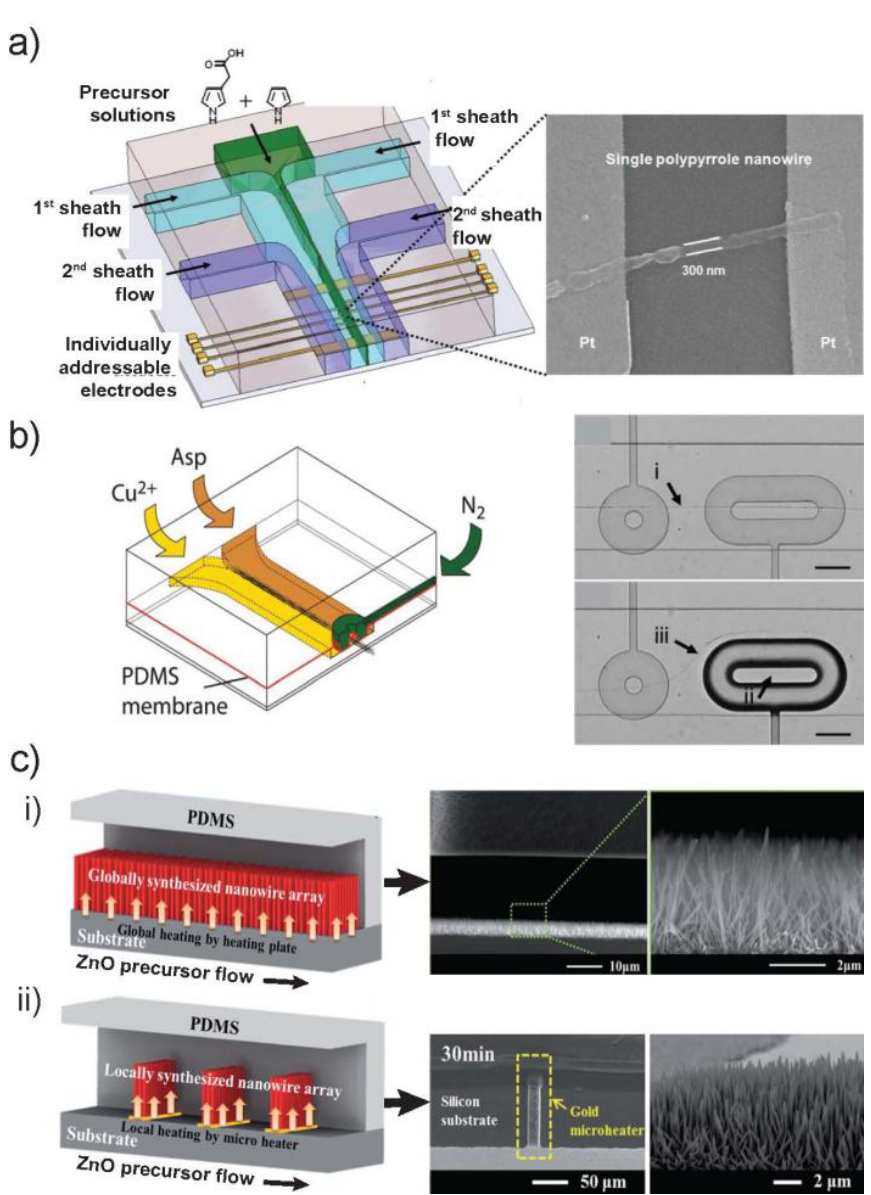
Figure 5. Alignment during synthesis. ( a ) Left: A microfluidic setup with a hydrodynamically focused laminar stream of two precursor solutions is used as a dynamic template for site-specific electrochemical deposition of size controllable conducting polymer micropatterns across individually addressable electrode junction pairs. Right: SEM image of 300-nm-wide Ppy nanopattern across a Pt electrode pair. ( b ) Left: Schematic illustration depicting the principle of formation and trapping of Cu(II)–Asp NW bundles. Right: The NWs are formed at the interface between the two reagent streams (indicated by ( i )). The position of the interface is determined by the flow rates of the two reagent streams. After actuation of the donut trap, the NWs are embedded inside the donut ( ii ), and a new assembly pathway is established ( iii ). ( c ) Schematics of in situ synthesis and integration of ZnO NWs in microfluidic chip: global synthesis in the entire fluidic channel (left up) and local synthesis by microheaters in the fluidic channel (left bottom). SEM images of ZnO NWs in microchannel: ( i ) globally synthesized (top and cross-sectional view) and ( ii ) locally synthesized by microheater. Images in ( a ) are reproduced with permission from [16], ( b ) from [54] (The Royal Society of Chemistry) and ( c ) from [30] (The Royal Society of Chemistry).